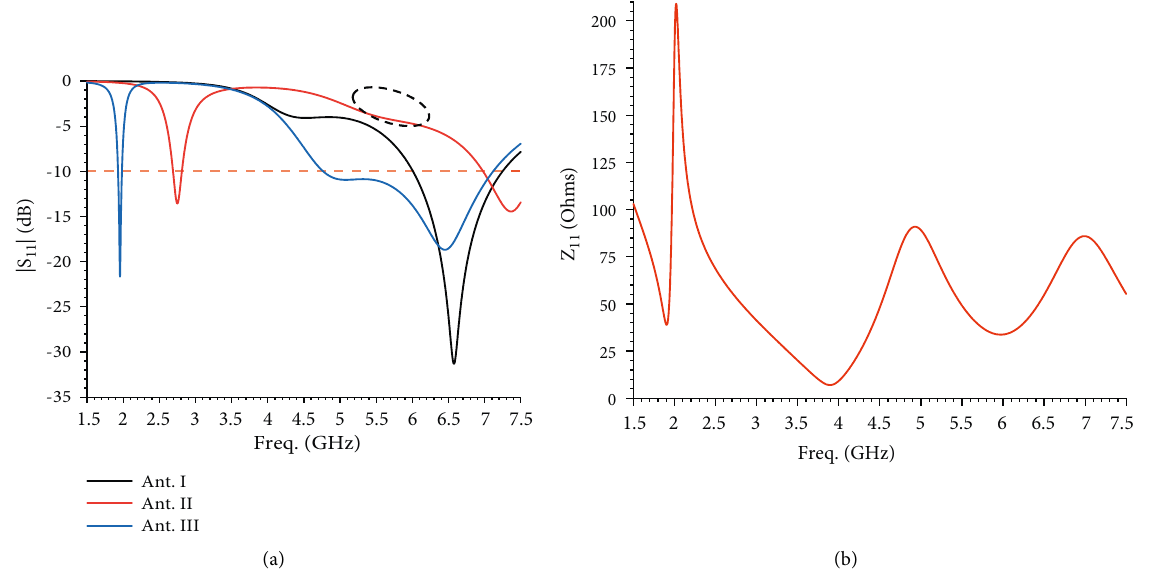
Figure 3: (a) |S11| Response of the Design Procedure and (b) the Input impedance of the antenna.